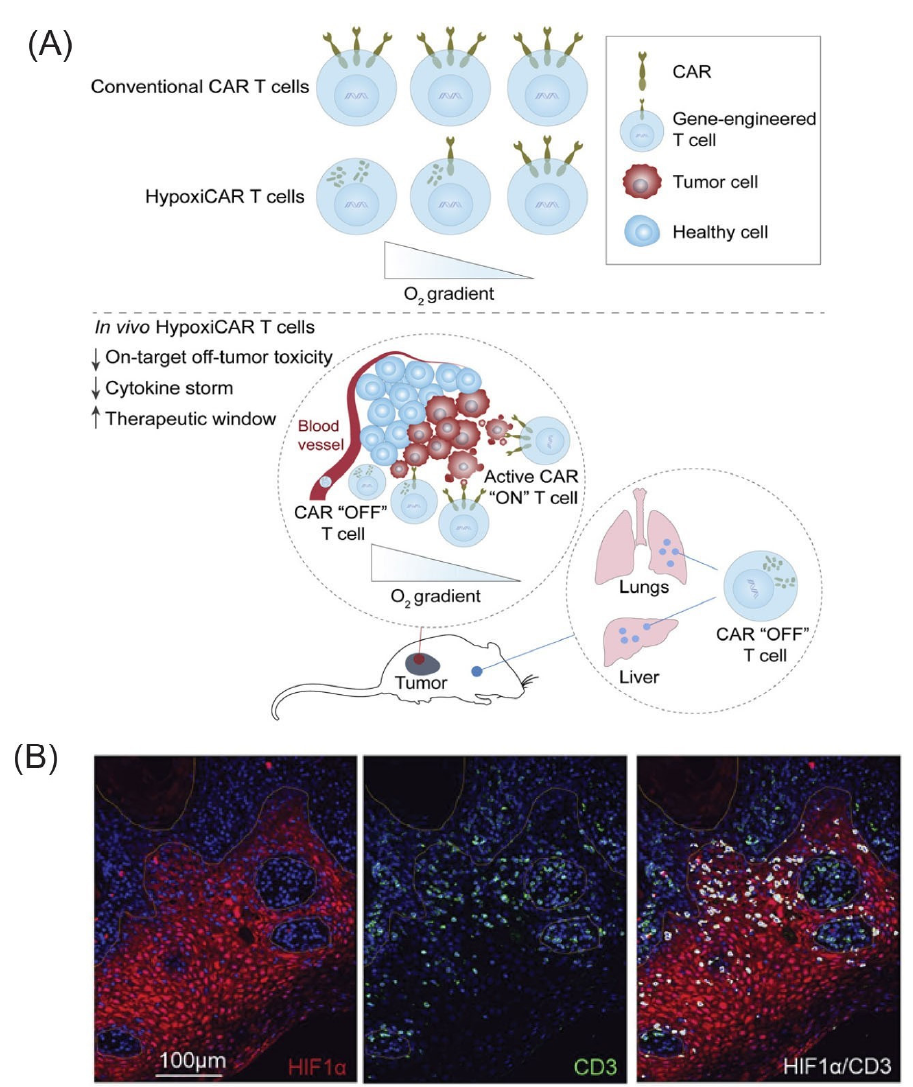
Figure 3. ( A ) Schematic of HypoxiCAR T-cell activation: A hypoxia-inducible CAR construct, whose transcription is mediated by HIF-1. ( ↑ means increase, ↓ means decrease) ( B ) HypoxiCAR T-cells are not excluded from HIF-1-stabilized regions of the tumor. Immunofluorescence images from a human oral tongue carcinoma. Nuclei are stained with DAPI (blue), anti-CD3 antibody (green), and anti-HIF-1 α antibody (red); white denotes CD3 and HIF-1 α co-localization. Scale bar 100 µ m. (Reprinted with permission from Elsevier. Copyright (2021) Cell Reports Medicine [426]).